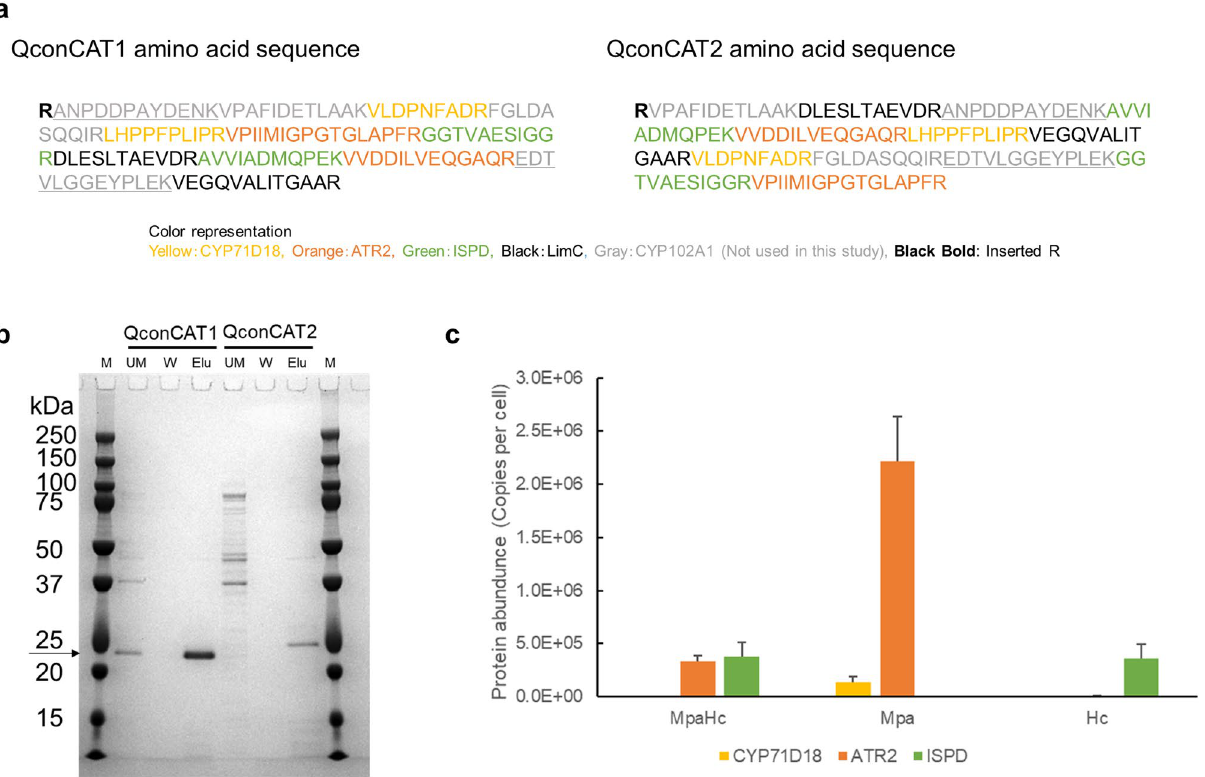
Figure 5. Quantification of enzyme expression level by proteome analysis using the quantification concatamer (QconCAT) method. To determine the optimum balance for converting limonene to carvone, quantitative proteome analysis using the QconCAT protein was conducted for strains expressing P450 (CYP71D18), CPR (ATR2), or CDH (ISPD). ( a ) QconCAT standard protein design. Two tryptic peptides were selected based on the preliminary study to represent each protein. The peptide sequences were concatenated in two different orders to produce QconCAT1 and QconCAT2. ( b ) Purification of QconCAT proteins. Sodium dodecyl sulfate– polyacrylamide gel electrophoresis (SDS-PAGE) image shows that QconCAT proteins (20 kDa, indicated by an arrow) were correctly expressed and purified. Applied samples per lane were indicated as follows; M: molecular mass standard marker, UM: material not bound to the his-tag column, W: wash fractions, Elu: elution fractions. Positions of molecular mass standards are indicated. ( c ) Quantitative proteome analysis using the QconCAT method. Unlabeled soluble proteins from strains expressing P450 (CYP71D18), CPR (ATR2), or CDH (ISPD) were mixed with labeled QconCAT, digested with trypsin and analyzed by nano-LC–MS/MS. The intensities of unlabeled and labeled peptides were used to calculate the absolute amounts of each protein, as copies of each protein per cell. The MpaHc strain (BL21(DE3) pCDF-CYP71D18-ATR2, pET-ISPD) expressed P450 (CYP71D18), CPR (ATR2), and CDH (ISPD). The Mpa strain (BL21(DE3) pCDF-CYP71D18-ATR2) expressed P450 (CYP71D18) and CPR (ATR2). The Hc strain (BL21(DE3) pET-ISPD) expressed CDH (ISPD). The protein abundance was calculated as an average of three independent clones. Error bars represent standard deviations of n =